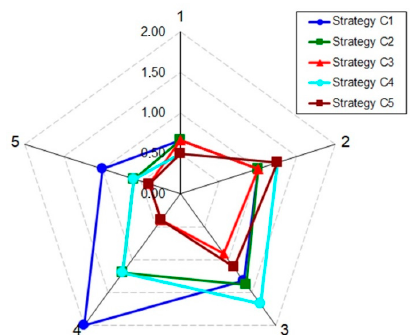
Figure 8. Comparison of converters’ parameters under strategies C1–C5: Ratios of number of switches (axis 1) and number of diodes (axis 2) to those in SCVM (on the basis of data in Table 3). Quantity proportional to undesired output voltage decrease: 0.06 · (200 – U out) (axis 3). Ratios of the lowest frequencies in the input and output current: 0.4 · f ac_in SCVM / f ac_in (axis 4), 0.4 · f ac_out SCVM / f ac_out (axis